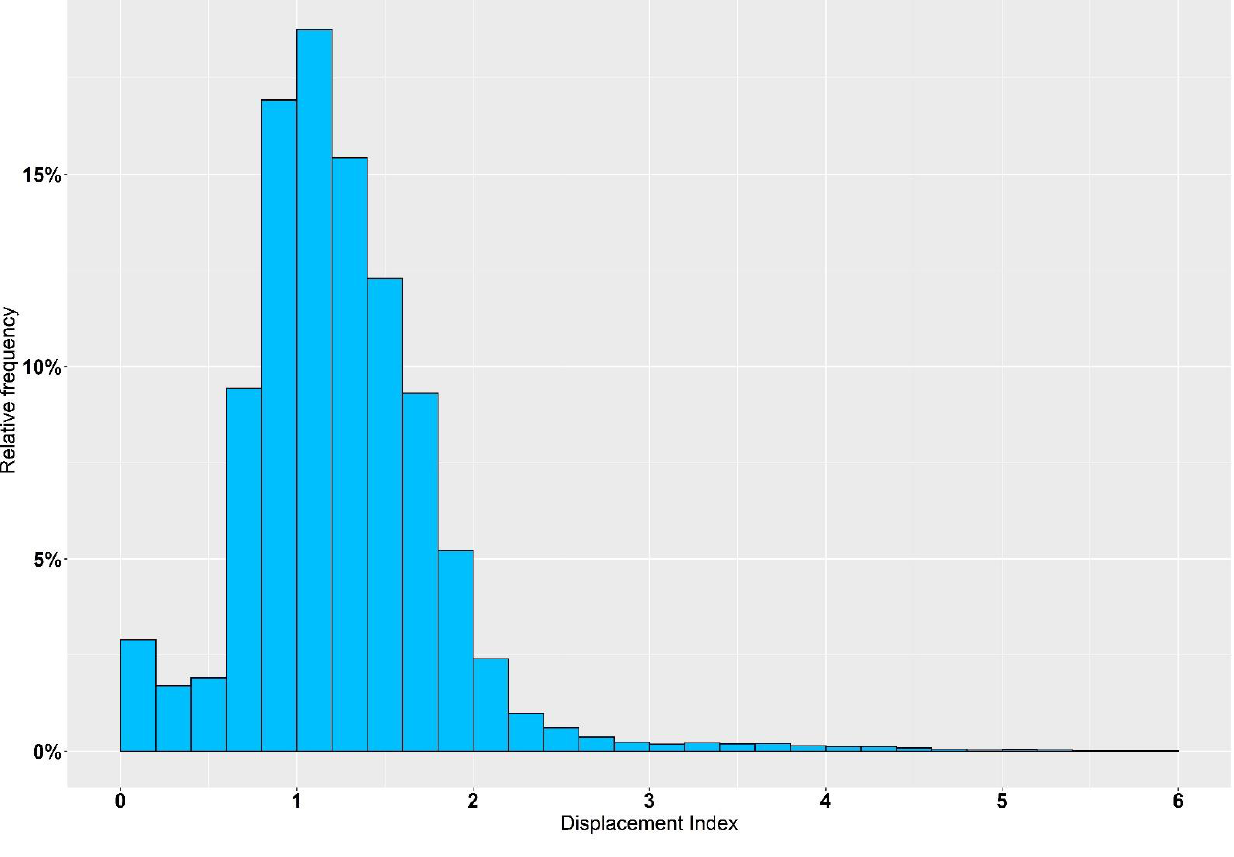
Figure 4. Summary of occurring Displacement Indices (D i ) on a reference delivery from a German AI center to several sow farms (distance = 800 km, t = 590 min).